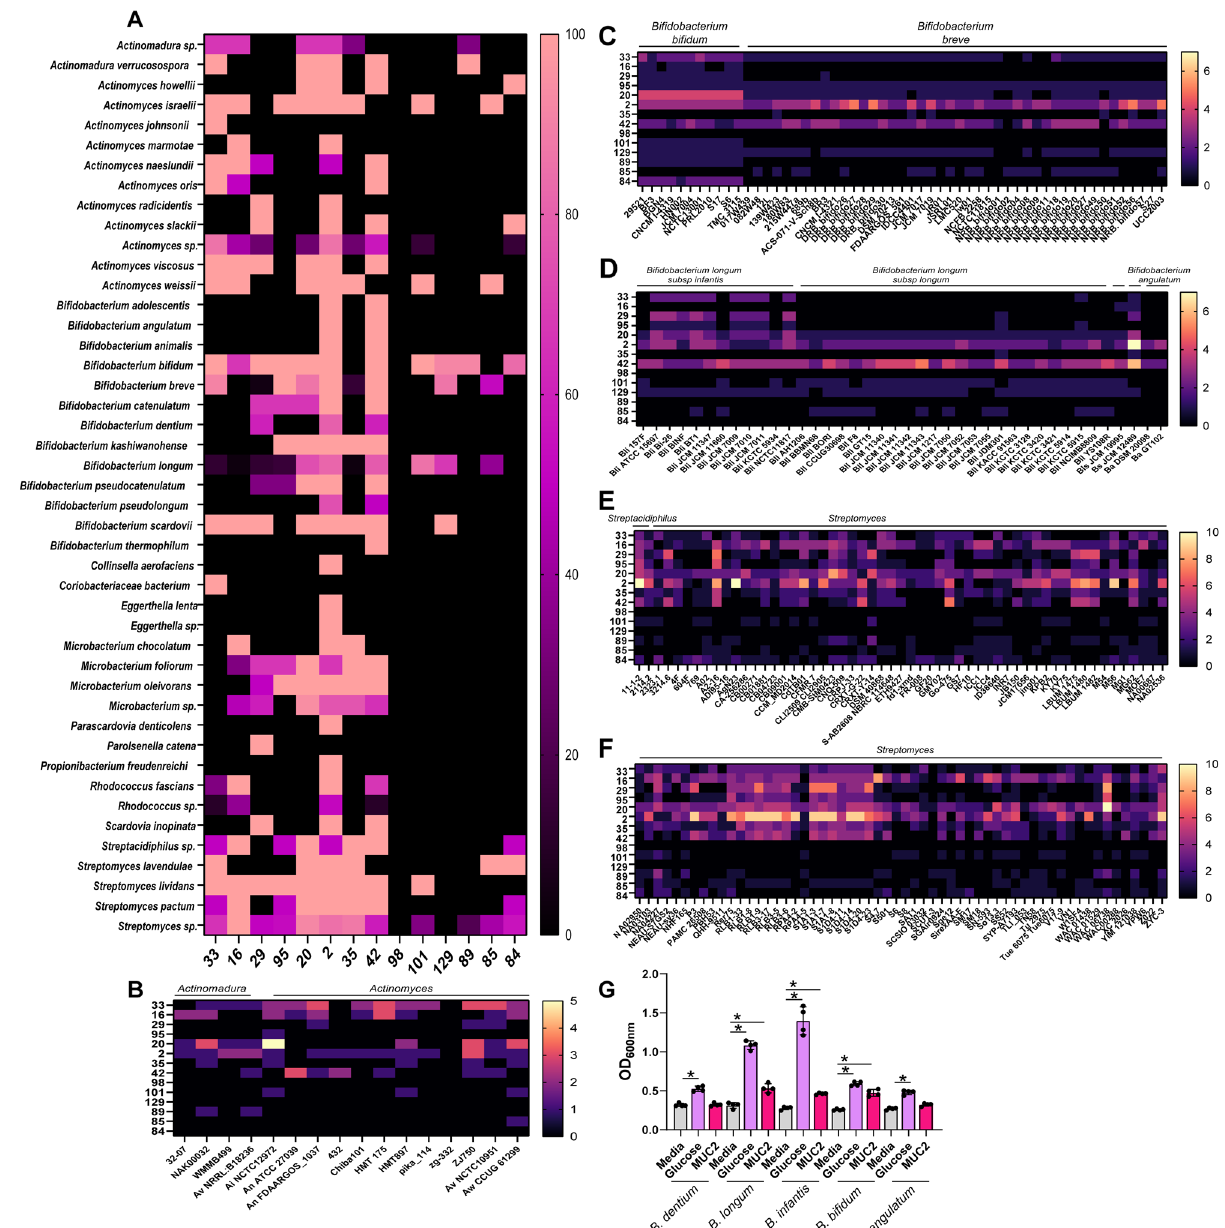
Figure 3. Mucin-related glycosyl hydrolase profiles in the Actinobacteria phlyum. ( A ) Heat map of the Actinobacteria genomes that have at least one gene copy of a mucin-associated GH 33, 16, 29, 95, 20, 2, 35, 42, 98, 101, 129, 89, 85, and 84. ( B ) Heat map showing the gene copy number of mucin-associated GHs in the strains of Actinomadura and Actinomyces, ( C ) Bifidobacteria, specifically B. bifidum and B. breve, ( D ) B. longum (Bl), B. longum subsp . infantis (Bli) , B. longum subsp . longum (Bll) , B. longum subsp . suillum (Bls), and B. scardovii , ( E ) Streptacidiphilus and Streptomyces species, and ( F ) Streptomyces species. ( G ) Growth analysis of Bifidobacterium dentium ATCC 27678, B. longum subsp. infantis ATCC 15697, B. bifidum ATCC 29521, B. longum ATCC 55813, and B. angulatum ATCC 27535 in a chemically defined media ZMB1 lacking glucose (media control), with glucose (positive control), or lacking glucose and supplemented with 1 mg/mL porcine intestinal MUC2. Growth was measured by examining the optical density at 600 nm (OD 600nm ) after overnight